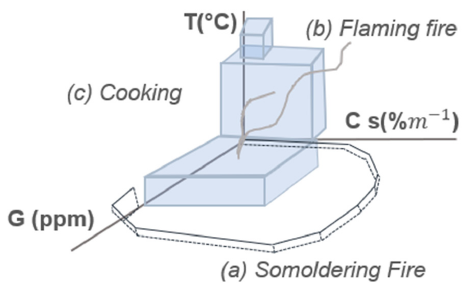
Figure 8. Defined fire regions when smoke detector (% obscuration per meter) is coupled with temperature ( ◦ C) and CO (ppm) measurements. Additional information provided from other sensors help to define more specific fire regions than when only smoke detector is used. The threshold planes were set to discriminate smoldering and flame fires (sensor signals a , b ) from cooking (sensor signal c ). During cooking, at the beginning, only temperature increases. As the food is becoming charred, smoke density increases, but no fire alarm is triggered as the signal stays within the defined non-fire region. Adapted from [8].